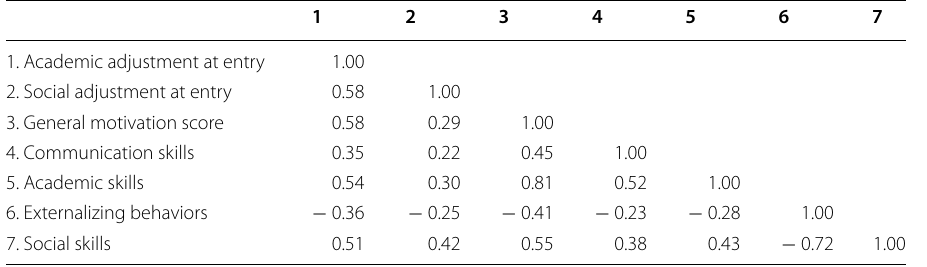
All correlations significant at p >